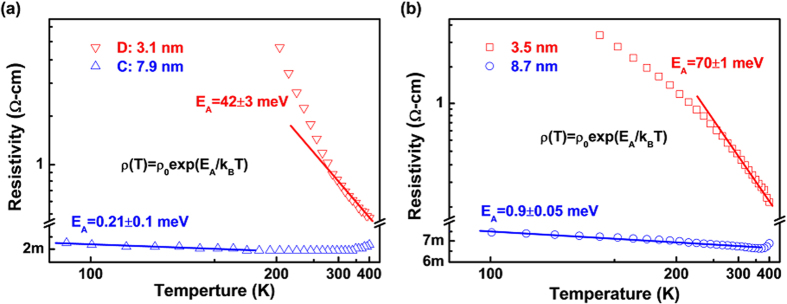
The activation energies of Sb in (a) SnO2:Sb10 films with thickness of 3.1 nm, 7.9 nm and (b) SnO2:Sb1 films with thickness of 3.5 nm, 8.7 nm.